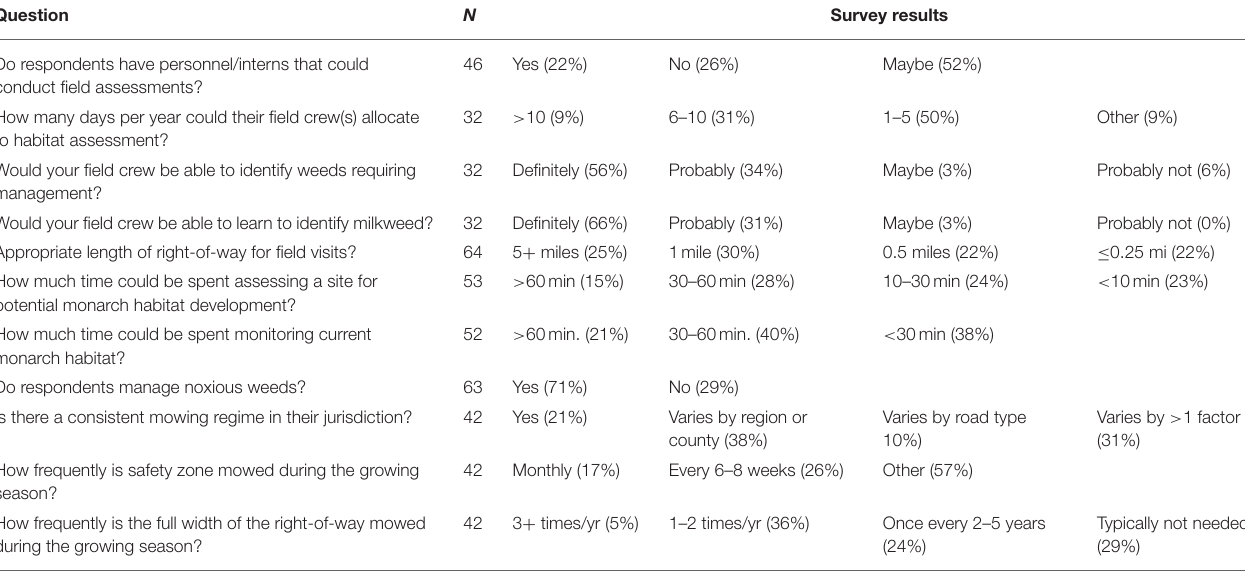
TABLE 2 | Responses by roadside managers to questions regarding roadside vegetation assessment and management (N, number of respondents). Question N Survey